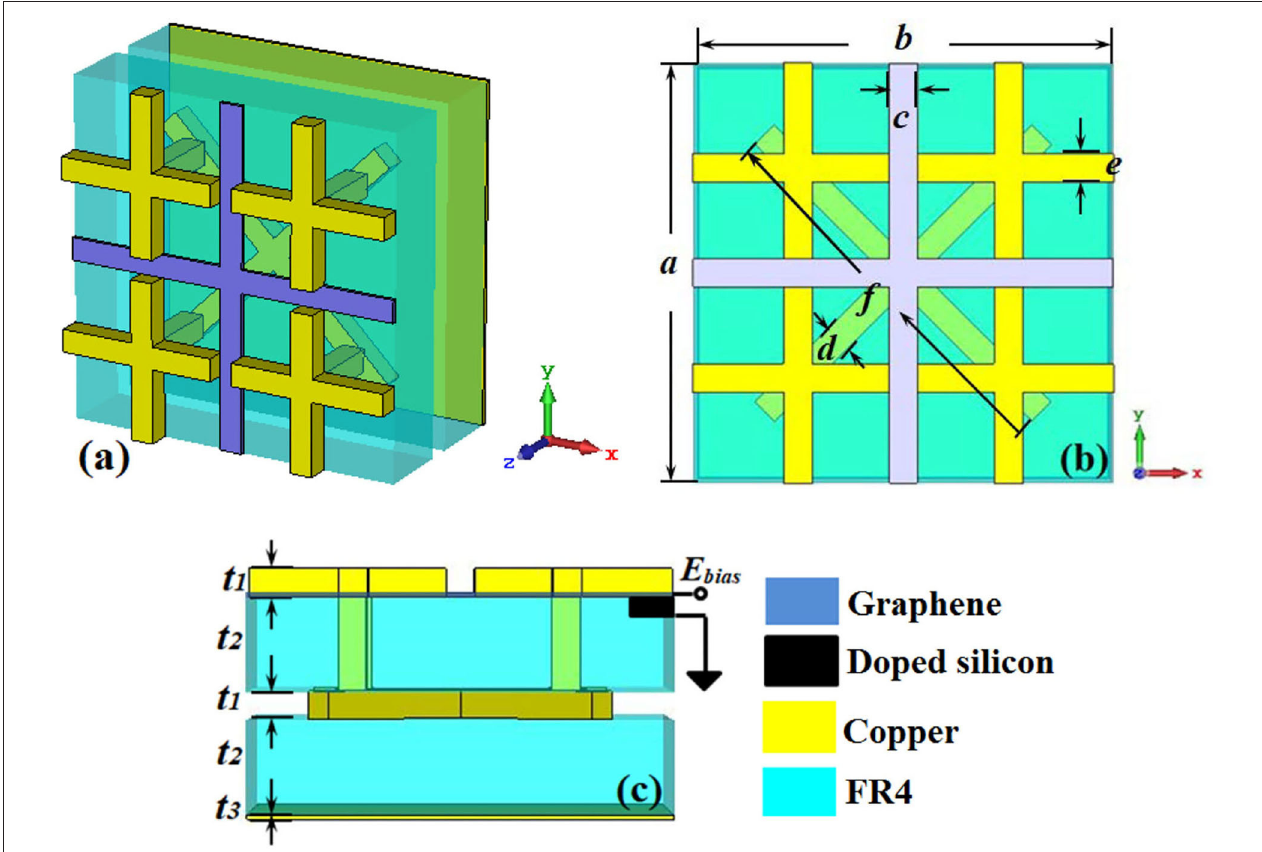
FIGURE 2 | The diagram of the metamaterial absorber unit cell: (A) perspective view, (B) front view, (C) side view.